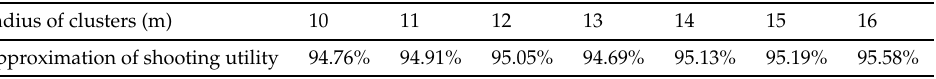
Table 3. Approximation of Shooting Utility Between UCR and OPT Algorithms Under Different Cluster Radius